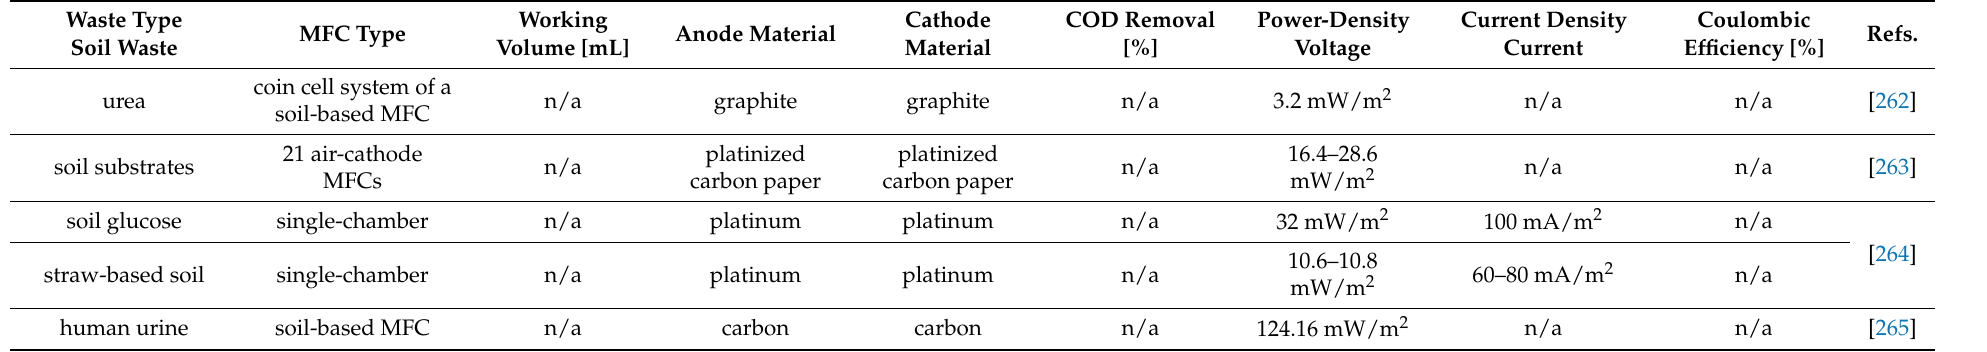
Table A10. Summary of studies reporting use of soil waste in